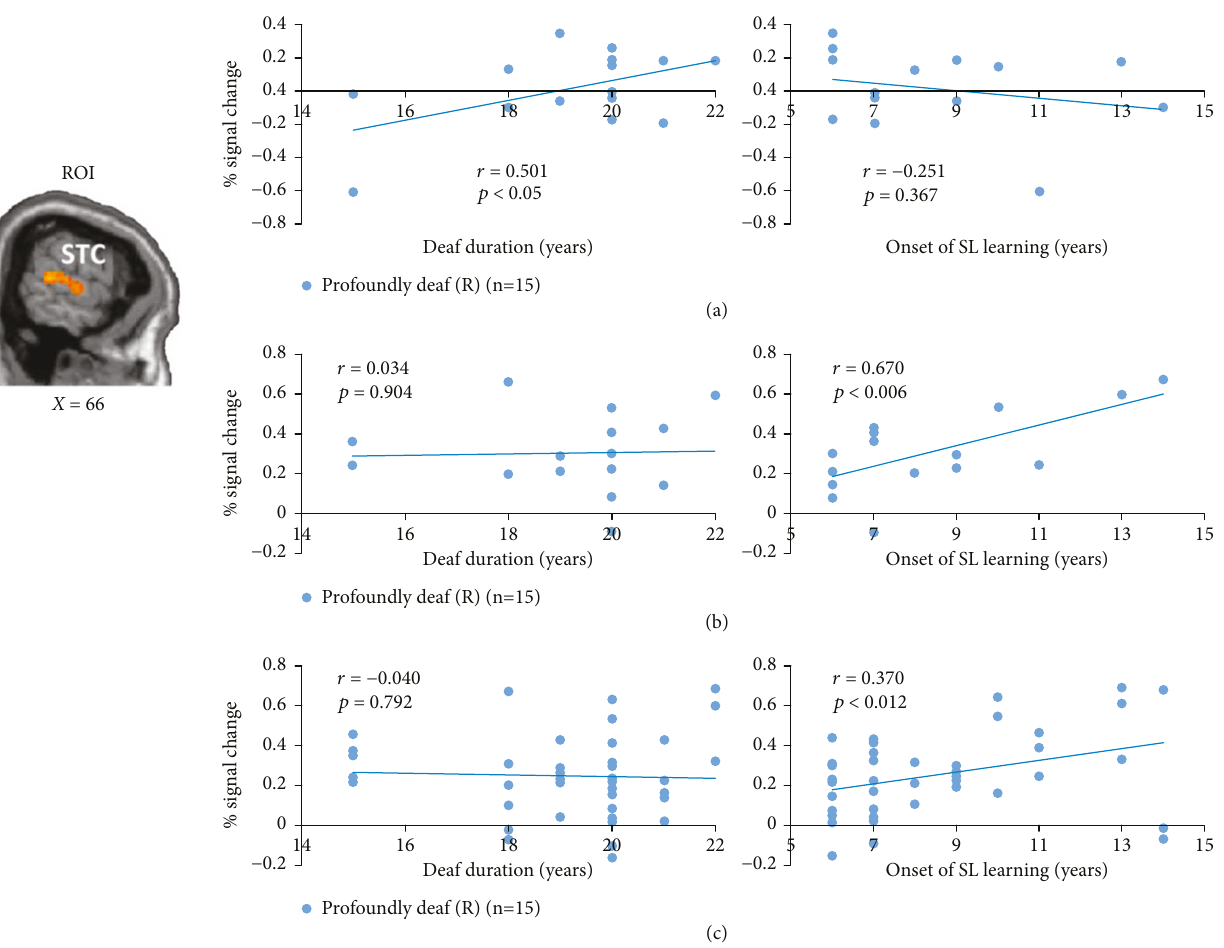
Figure 3: Correlations between superior temporal cortex (STC) activations and duration of deafness and onset of sign language learning in the profoundly deaf group. (a) A sagittal slice depicting the STC region of interest (ROI, selected based on the brain map showing the Group e ff ect, Figure 2(b)) in the right hemisphere. Signi fi cant correlations were found in the profoundly deaf group ( n = 15 ) between right STC activity for the checkerboard and duration of deafness ( r = 0 501 , p < 0 05 , Bonferroni corrected), but not between this activation and the onset of sign language learning (the age of starting to learn sign language) ( r = − 0 251 , p = 0 367 ). (b) In contrast, signi fi cant positive correlation was found between the activation for sign language and the onset of sign language learning ( r = 0 670 , p < 0 006 , corrected), but not between the activation and hearing loss duration ( r = 0 034 , p = 0 904 ). (c) In the profoundly deaf group ( n = 15 ), the STC activity induced by all the visual language stimuli (including words, sign language, and lip-reading) was correlated with the onset of sign language learning ( r = 0 370 , p < 0 012 , corrected), but not with the duration of deafness ( r = − 0 04 , p = 0 792